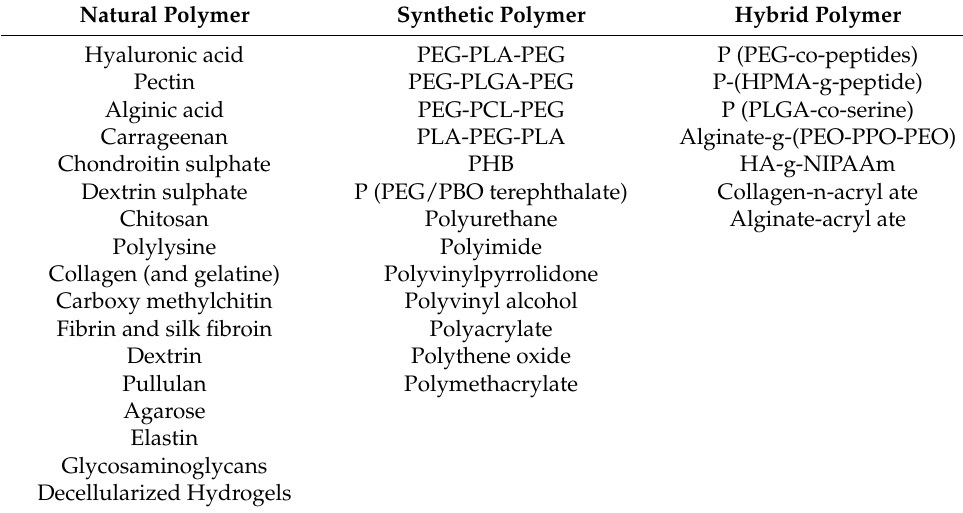
Table 1. Polymers commonly used in various hydrogel